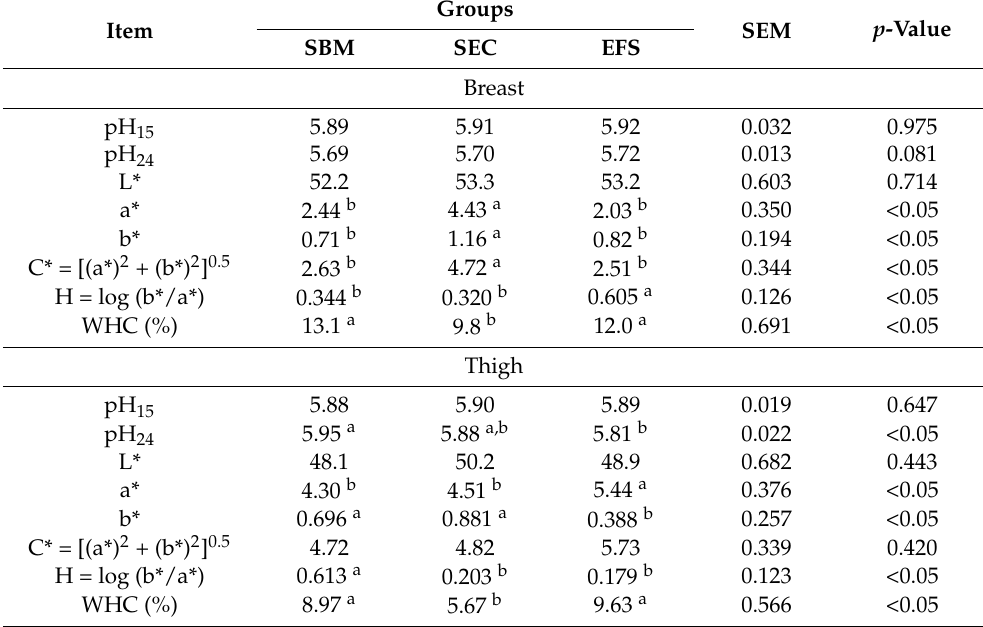
Table 7. Physical properties of muscles.